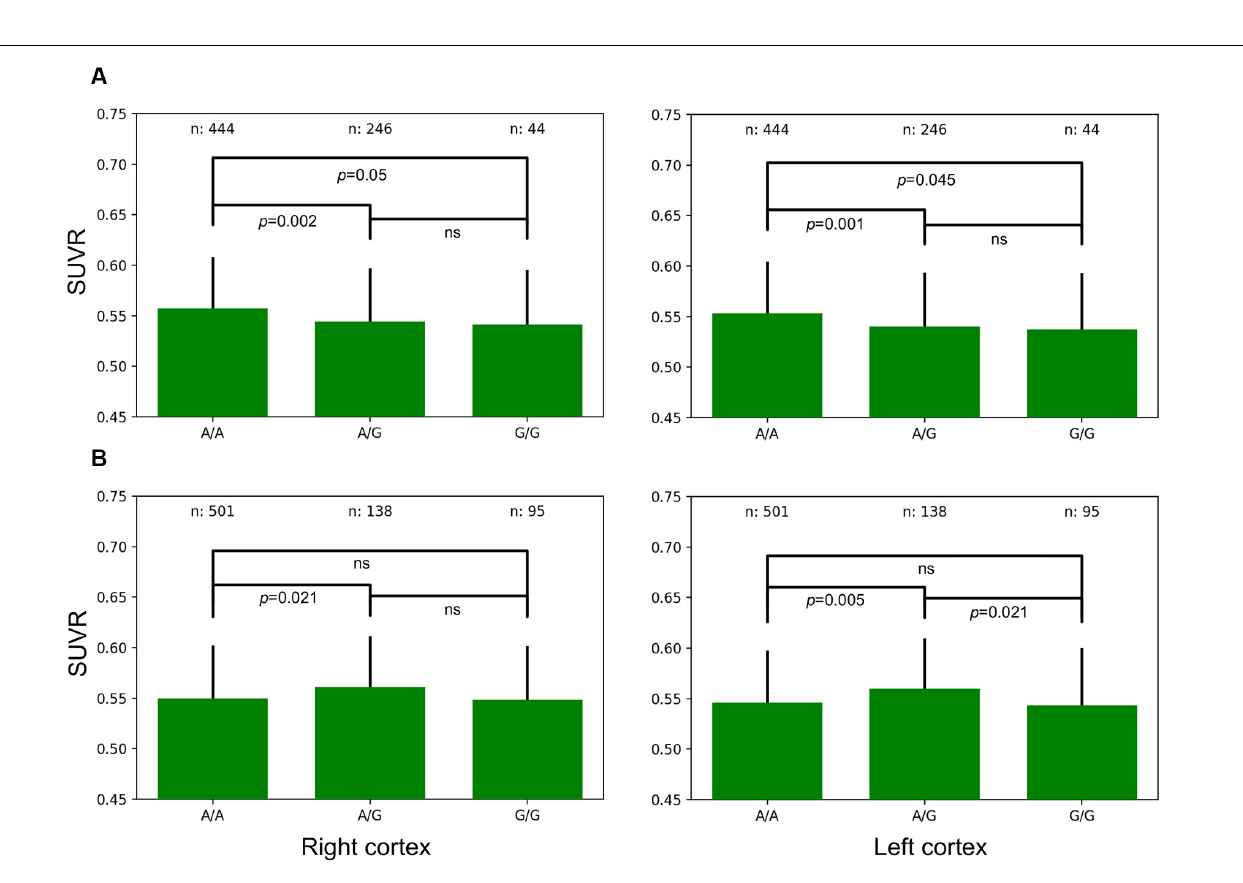
FIGURE 4 | Left and Right whole-brain cortical SUVR expressed as a function of allele frequencies for TOMM40 (A) and DUSP9 (B)